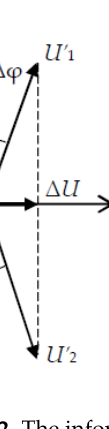
output voltages without rotation, U’ 1 , U’ 2 are the output voltages under rotation) .